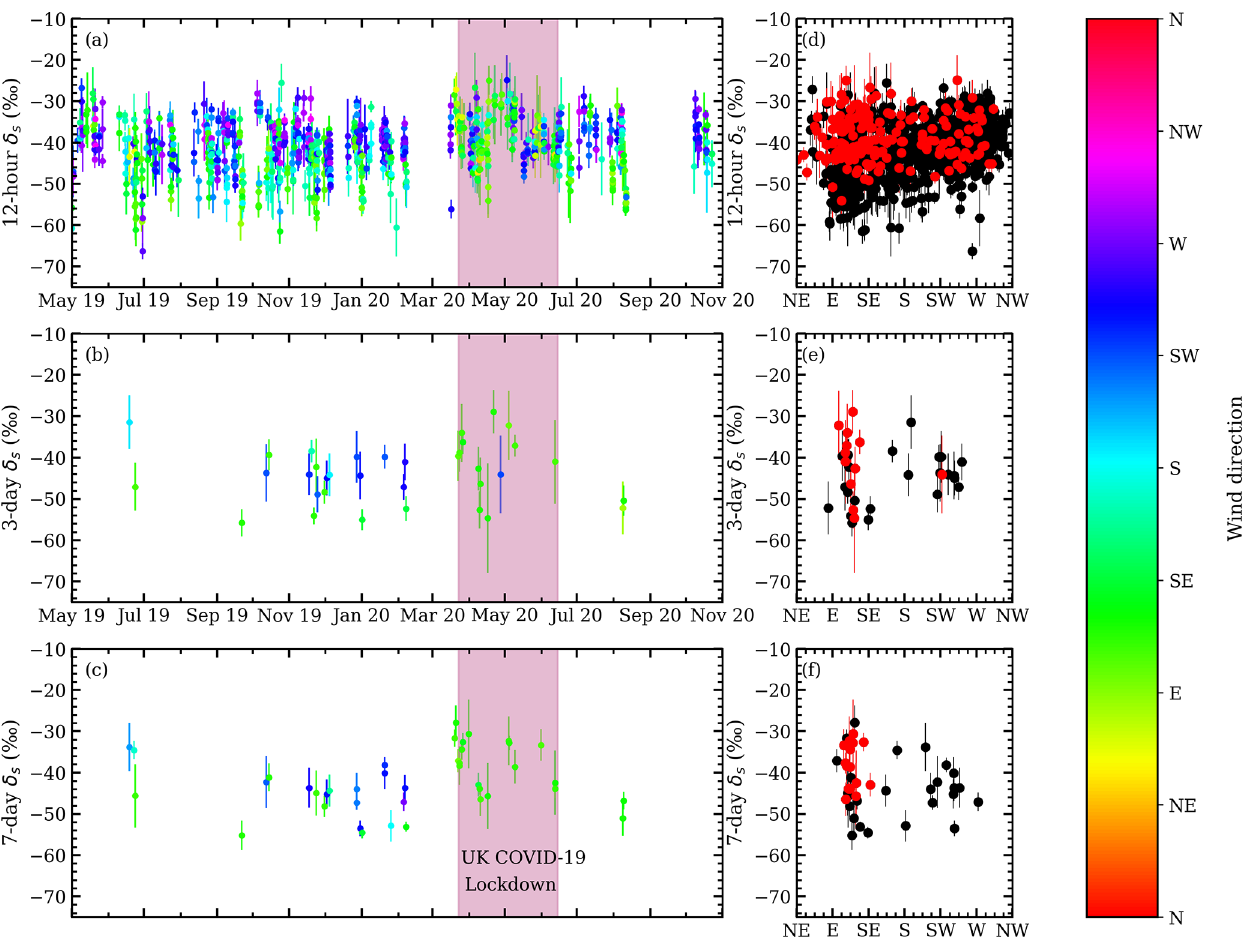
Figure 8. Time-series of isotopic source values for (a) 12h, (b) 3d, and (c) 7d windows. The marker colour denotes the mean wind direction from the start of the window to the peak of the pollution event. Black markers indicate times when wind direction data were not available. The UK COVID-19 lockdown period is shown in pink. Isotopic source values and wind direction comparisons for each of the moving windows are shown in panels ( d – f ). Red markers denote the period of the first UK COVID-19